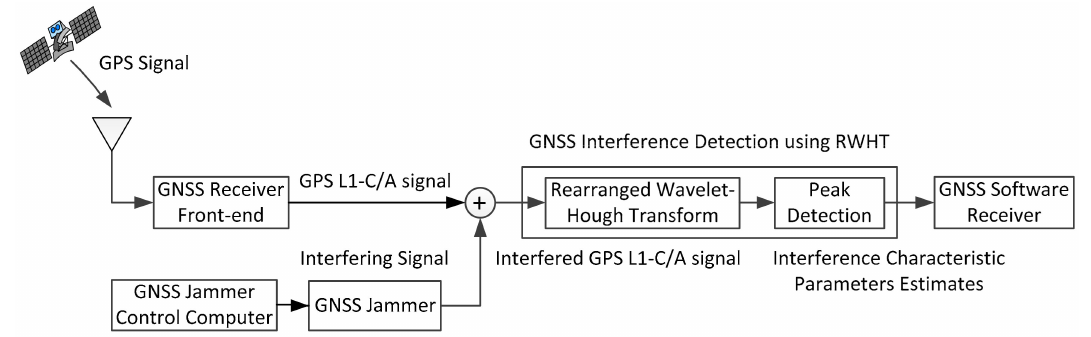
Figure 7. The scheme of the GNSS interference detection test in the